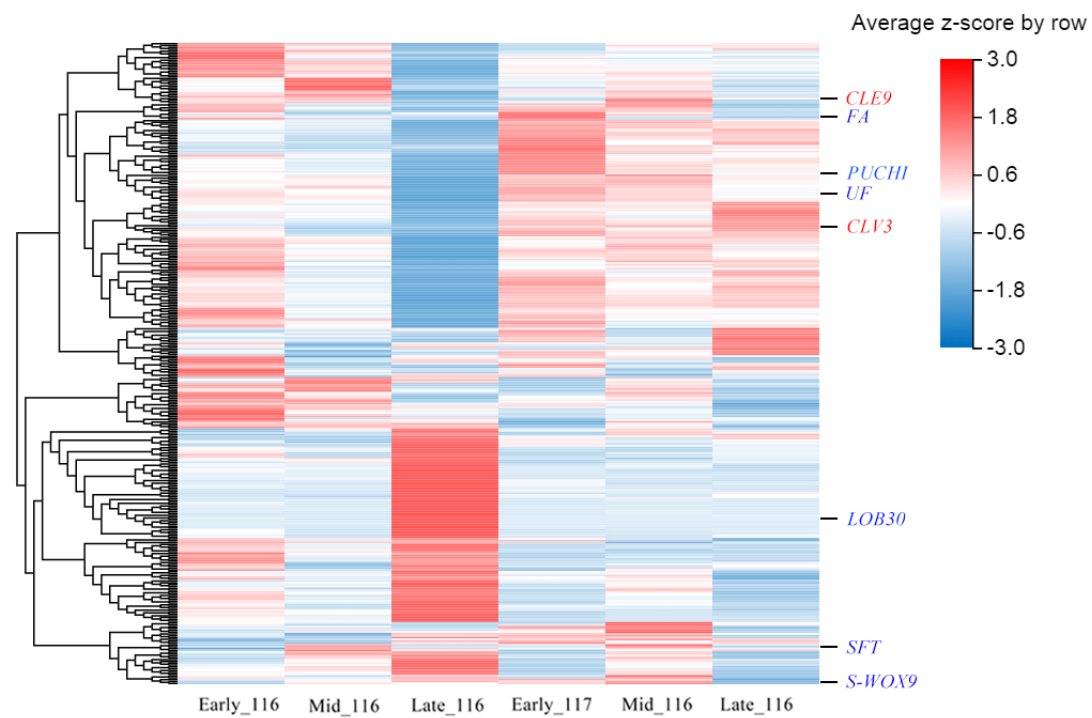
Figure 7. Heatmap of 351 gene clusters associated with flowering time.